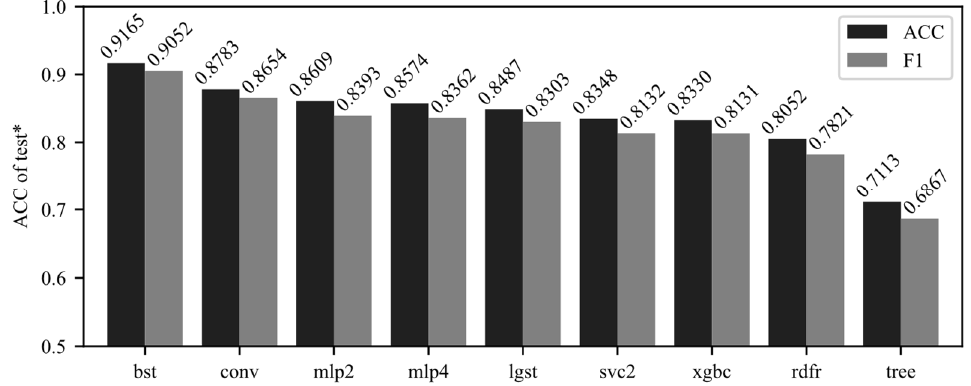
Figure 8. Accuracy and F1 score of all models in research.